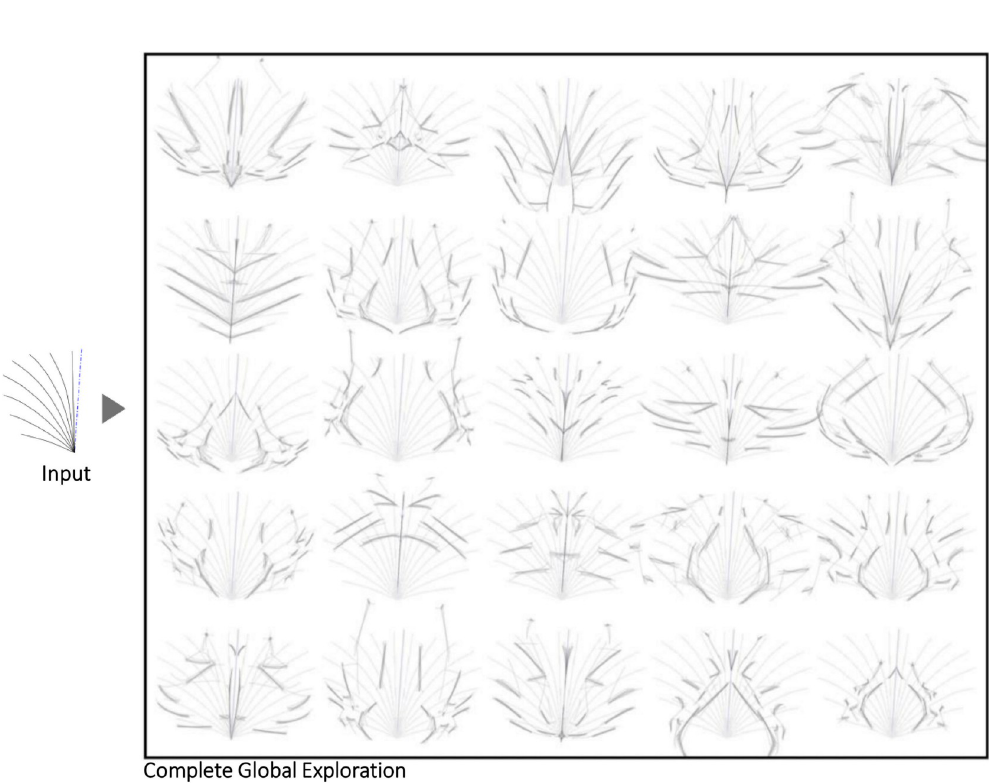
Fig 15. Example of an output sheet for the Shapi Global Exploration of an abstract input